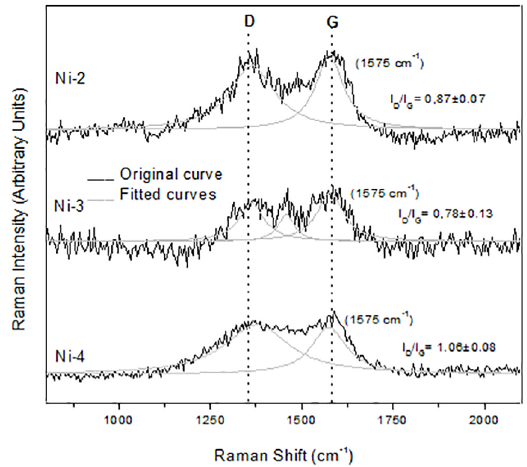
Figure 7. Raman spectra of the samples where the carbon films were deposited: (a) during 30 minutes in sample Ni-2, (b) during 60 minutes in sample Ni-3 and (c) during 90 minutes in sample